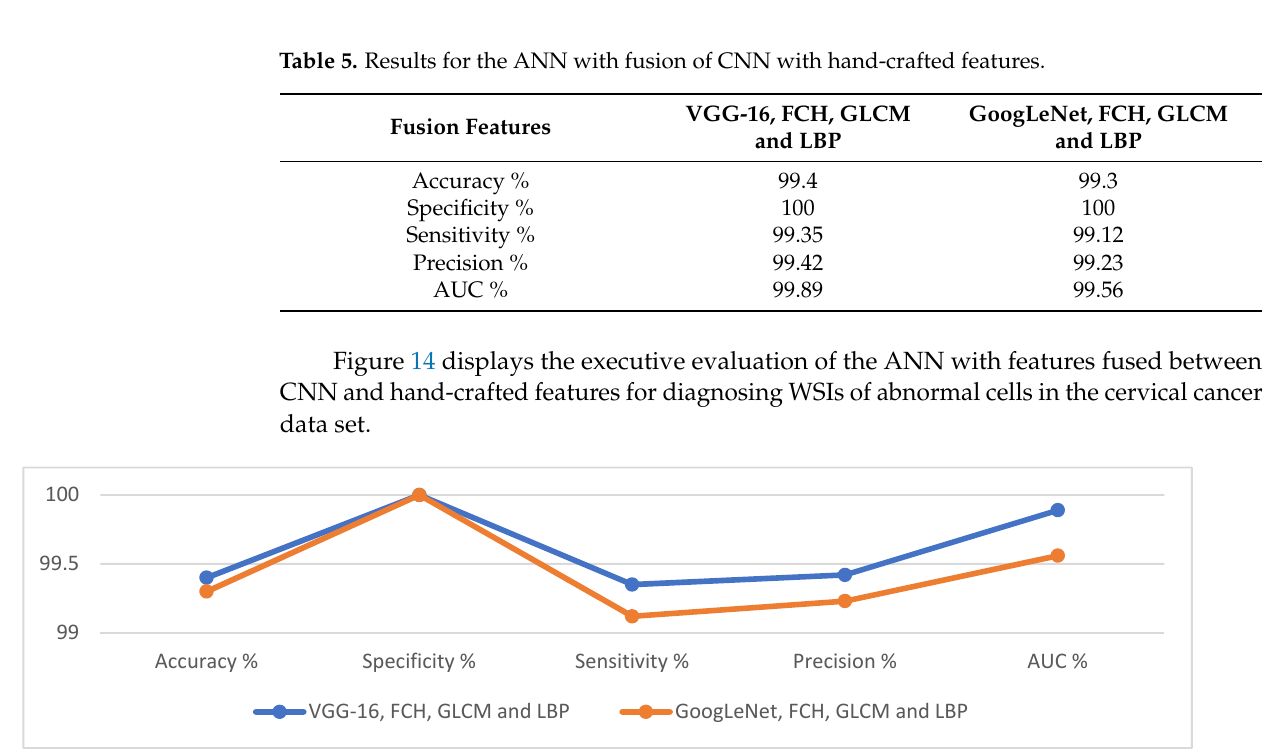
Figure 14. Presentation of the executive of the ANN with fusion features for diagnosing abnormal cervical cells.